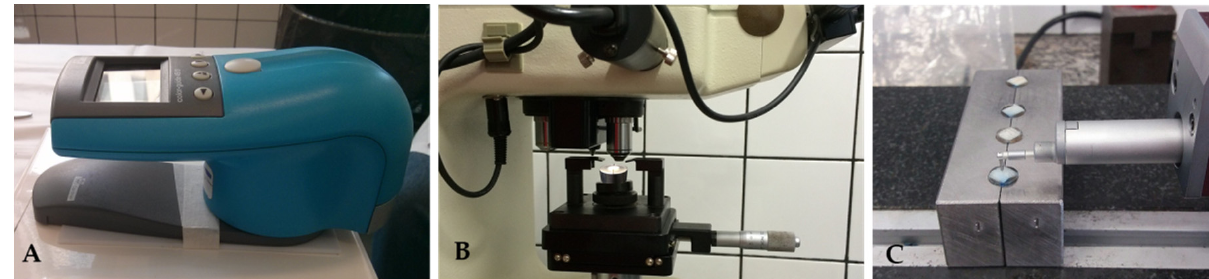
Figure 2. The measurement procedures used: color reading by a colorimetric spectrophotometer ( A ); microhardness, using a digital microhardness tester machine ( B ); and the surface roughness, measured by a surface roughness measuring instrument ( C ).